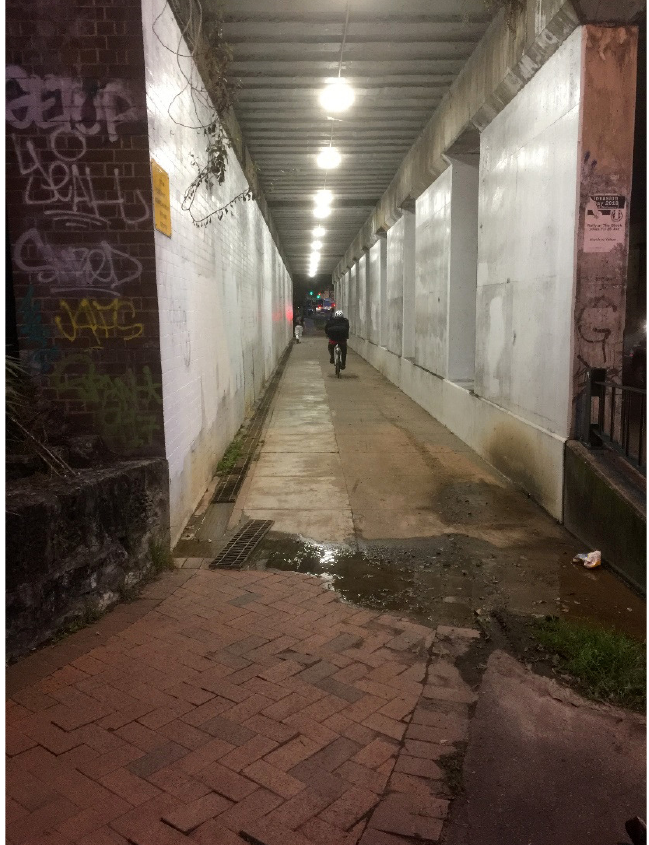
Figure 5. Underpass under the railway tracks in Upper